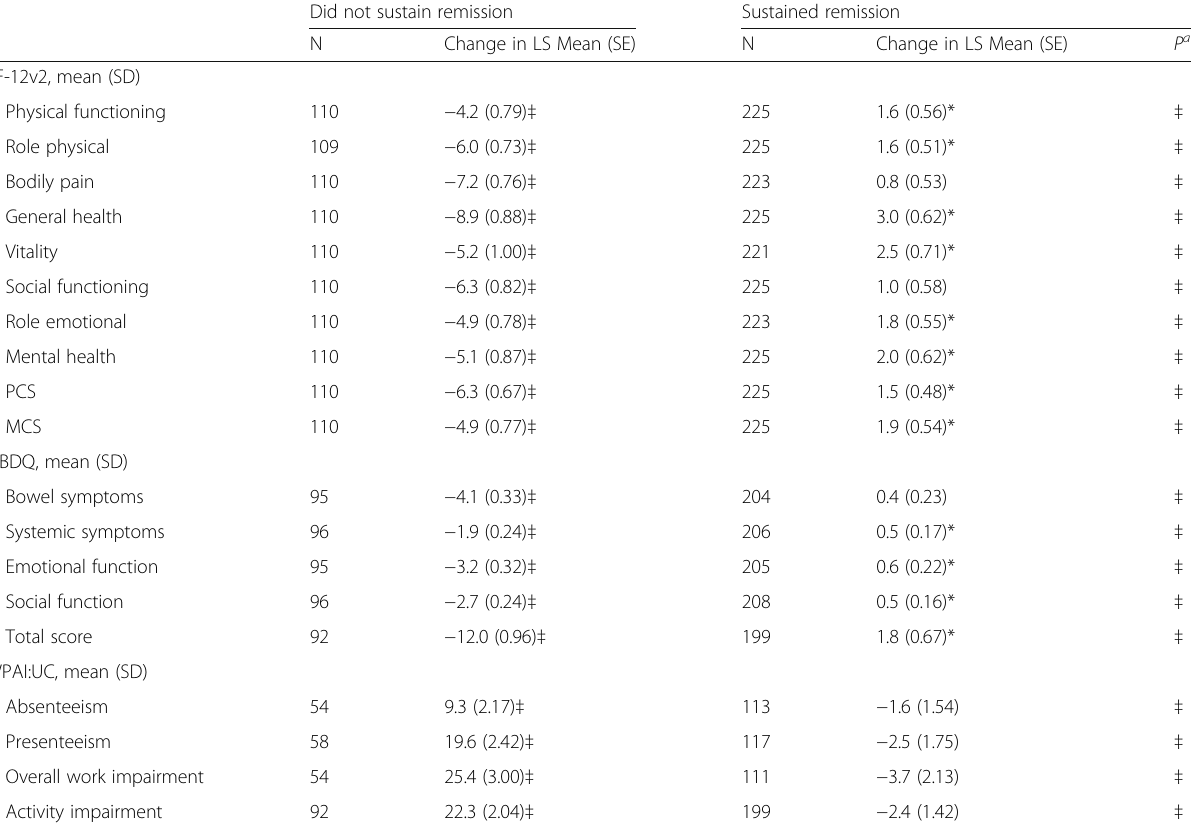
LS least squares, MCS mental component summary, PCS physical component summary, PRO patient-reported outcome, SD standard deviation, SE standard error, SF-12v2 SF-12v2 Health Survey, SIBDQ Short Inflammatory Bowel Disease Questionnaire, WPAI:UC Work Productivity and Activity Impairment questionnaire for ulcerative colitis Findings for each outcome are based on mixed-effects models for repeated measures with subject as a random effect, and sustainer status, visit, and the sustainer status x visit interaction as fixed effects Week 8 includes early withdrawal visits during the acute phase. “ Month 12 ” includes early withdrawal visits during the maintenance phase a Indicates statistical significance of the sustainer status x visit interaction